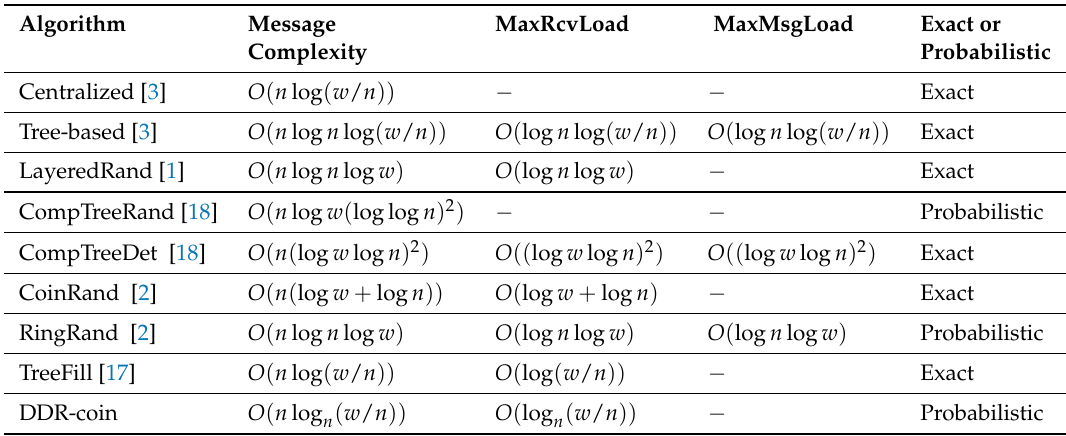
Table 1. Comparison of distributed trigger counting (DTC) algorithms.